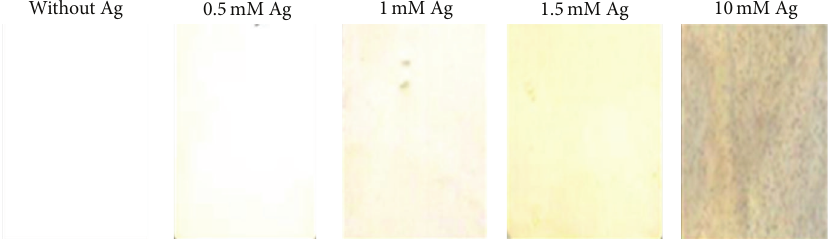
Figure 2: SEM image of the nylon-6,6 membrane.